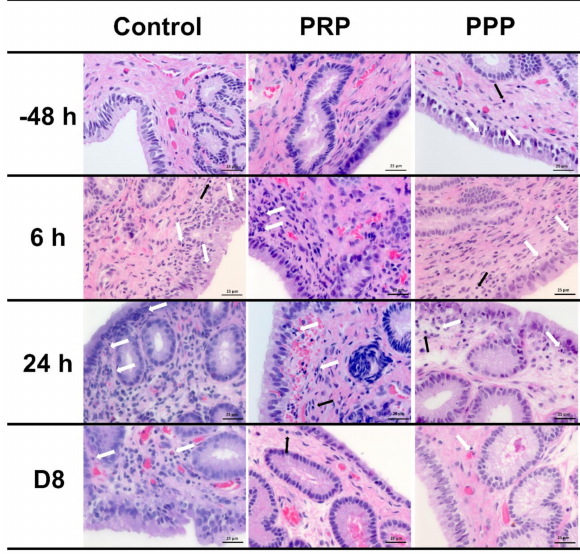
Figure 3. Representative images of H&E-stained endometrial biopsies collected from mares suscepti- ble to persistent breeding-induced endometritis pre- ( − 48 h) and post-breeding (6 and 24 h), and on the day of embryo flushing (eight days post-ovulation, D8). Mares were treated with four intrauterine infusions of Lactated-Ringer’s solution (Control), platelet-rich (PRP), or -poor plasma (PPP). White arrows indicate neutrophils and black arrows indicate lymphocytes. Magnification ×